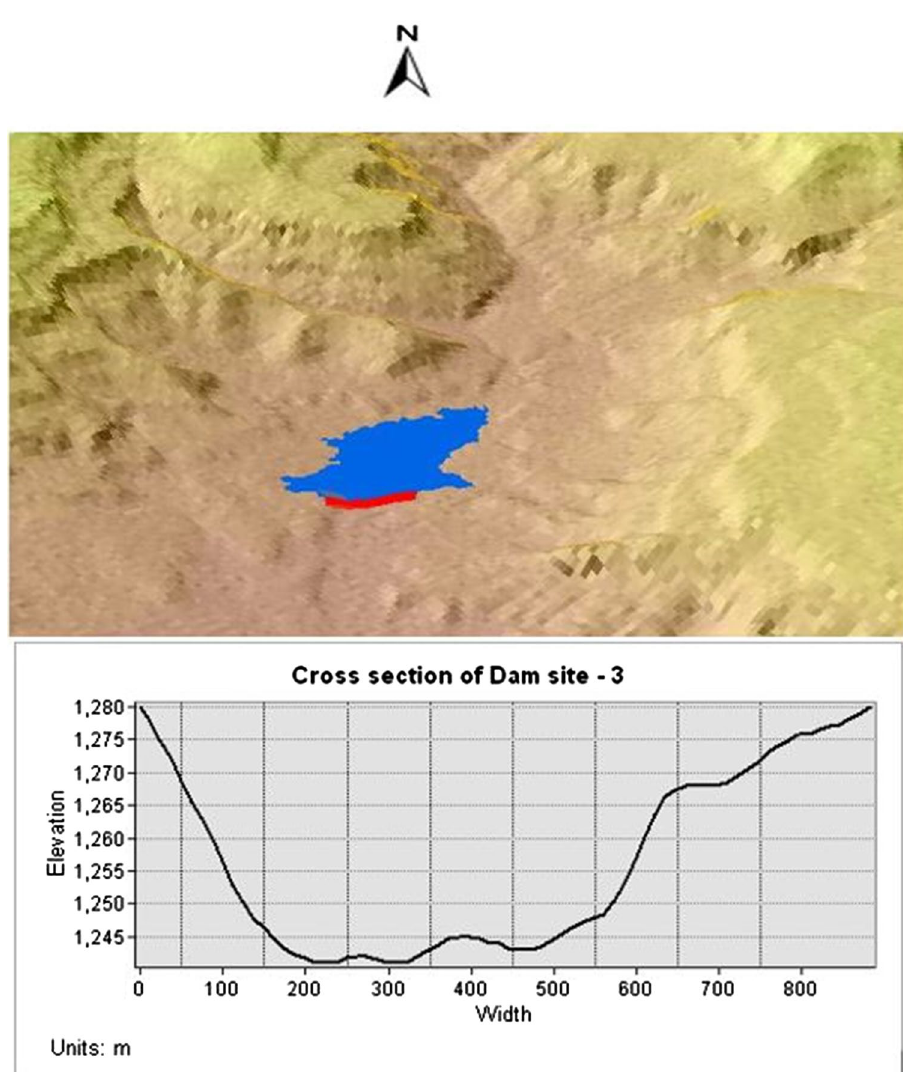
Fig. 17 3D view and cross sec- tion of proposed dam